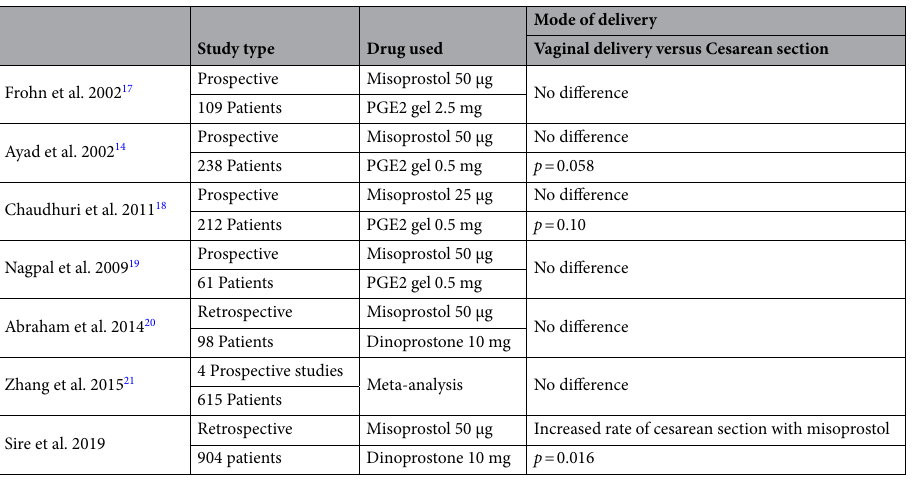
Table 8. Comparative studies of misoprostol and